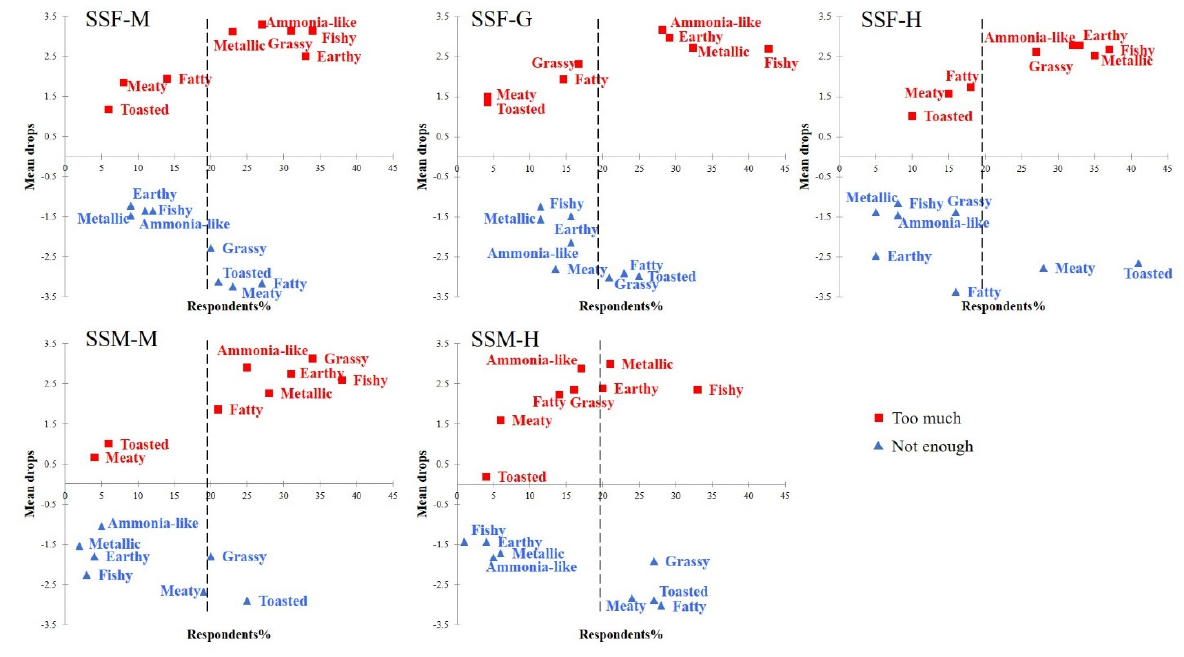
Figure 4. Just-about-right (JAR) percentages of consumer response for sensory attributes in three edible parts of E. sinensis (female/male) from Shanghai (n = 96). The mean drops indicate that the extent of the overall consumer preference decreases when the attribute’s intensity deviates from the ideal. M: crab meat, G: gonads, H: hepatopancreas. Consistent with the overall preference results, female and male crabs exhibited similar results, except for the gonads. Ammonia-like (mean drop = 3.30/2.90), grassy (mean